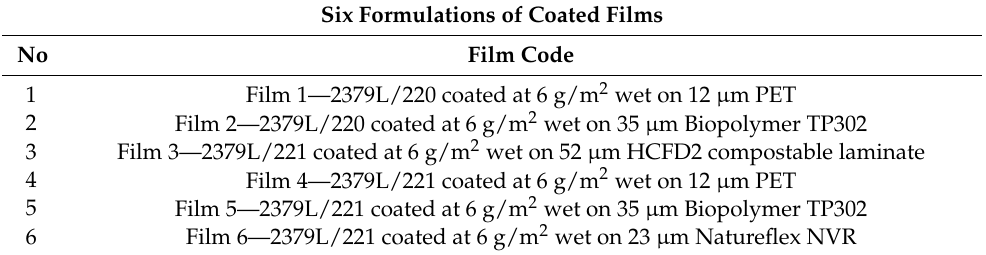
Table 2. Six formulations of coated